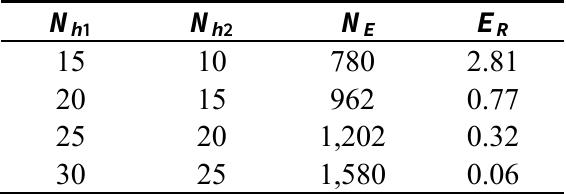
Table 3. Same as Table 2, but for N = N r